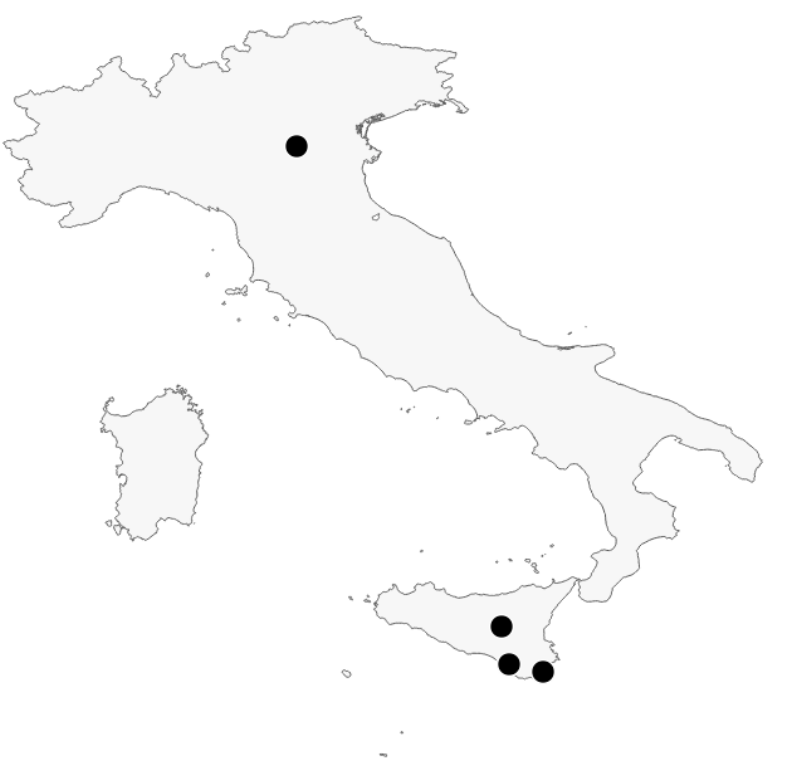
Figure 1. Location of study